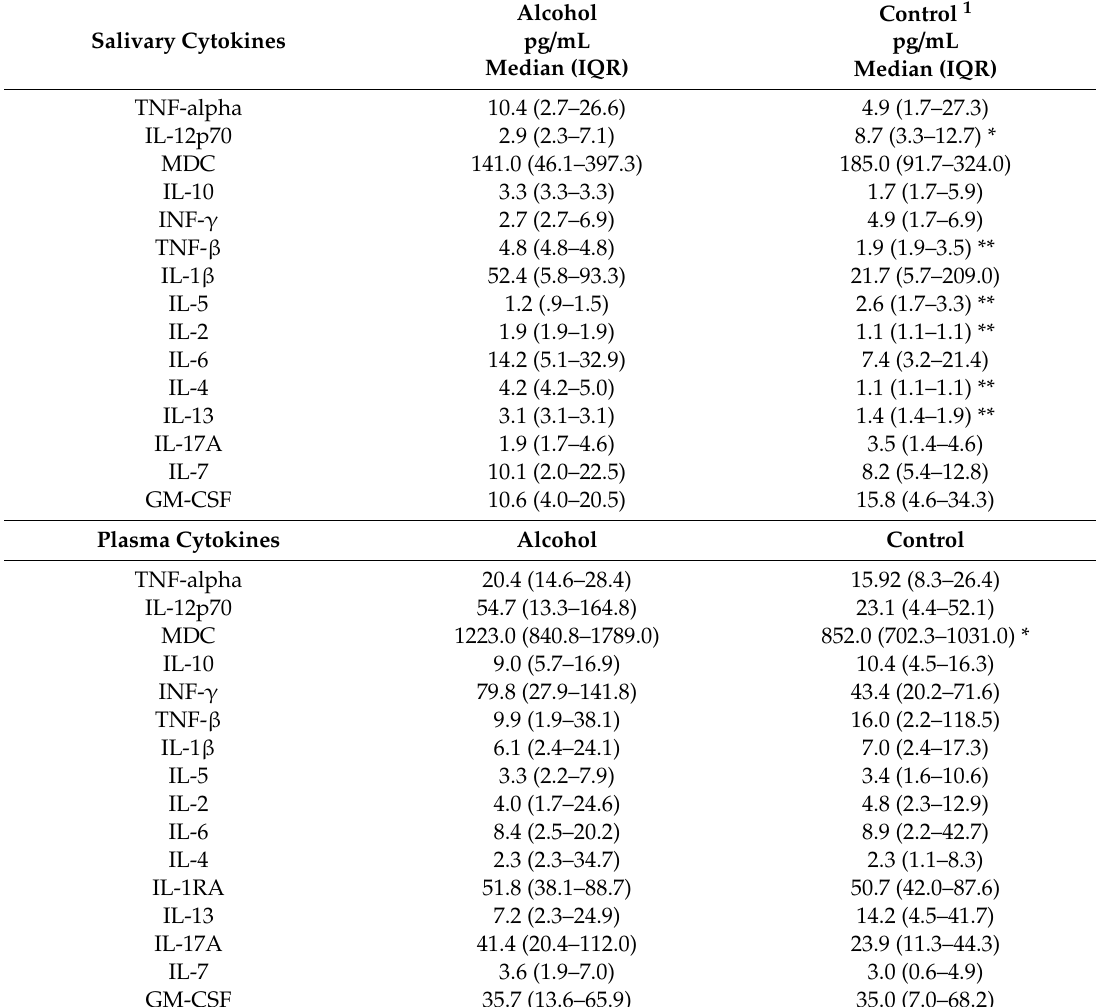
Table 4. Cytokine levels in the saliva and plasma samples.